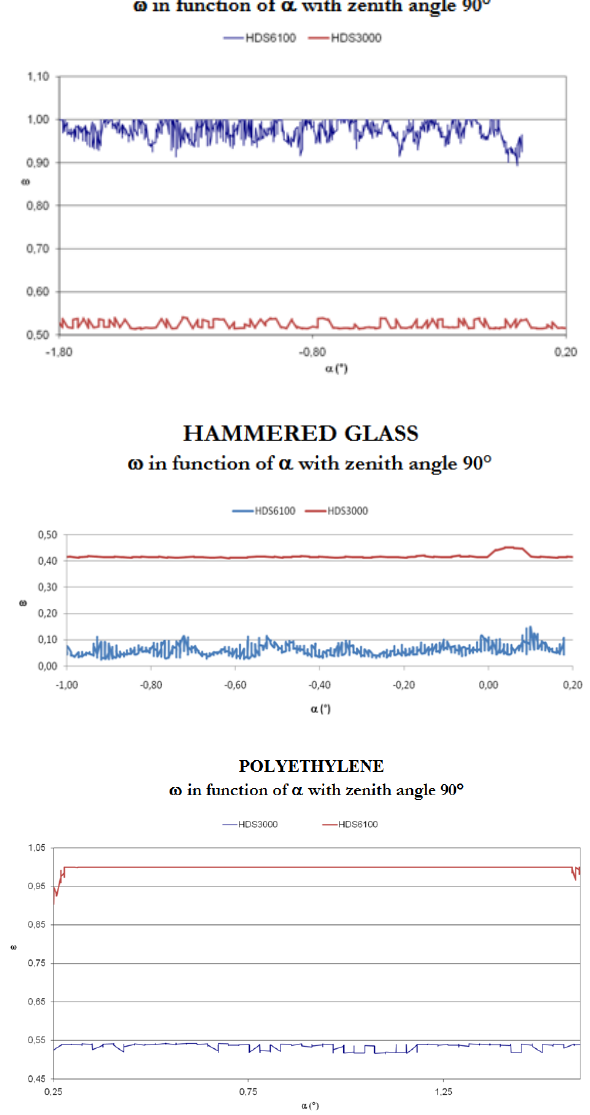
Figure 10 – Comparison between HDS 3000 and HDS